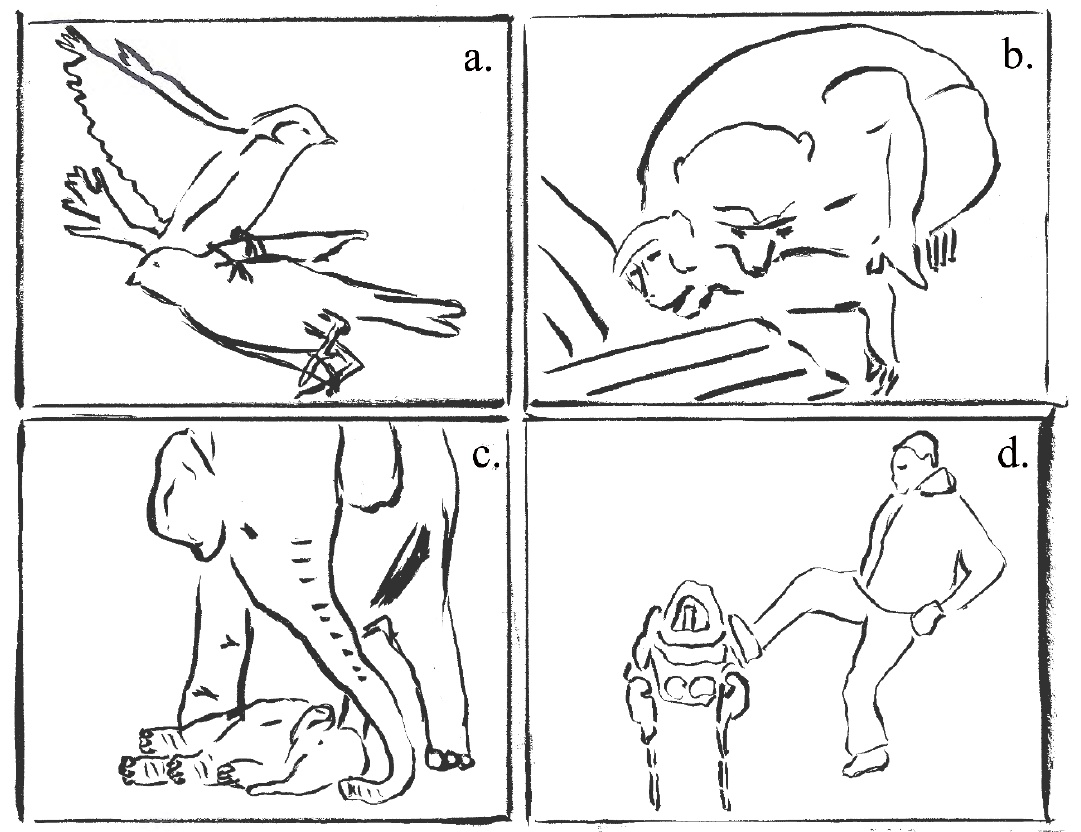
Figure 1. Drawings of the different epimeletic behaviours of ( a ) a sparrow, ( b ) a rhesus macaque, ( c ) an elephant towards an unconscious conspecific. ( d ) An engineer kicking a dog-robot. Picture credit: Cédric Sueur.